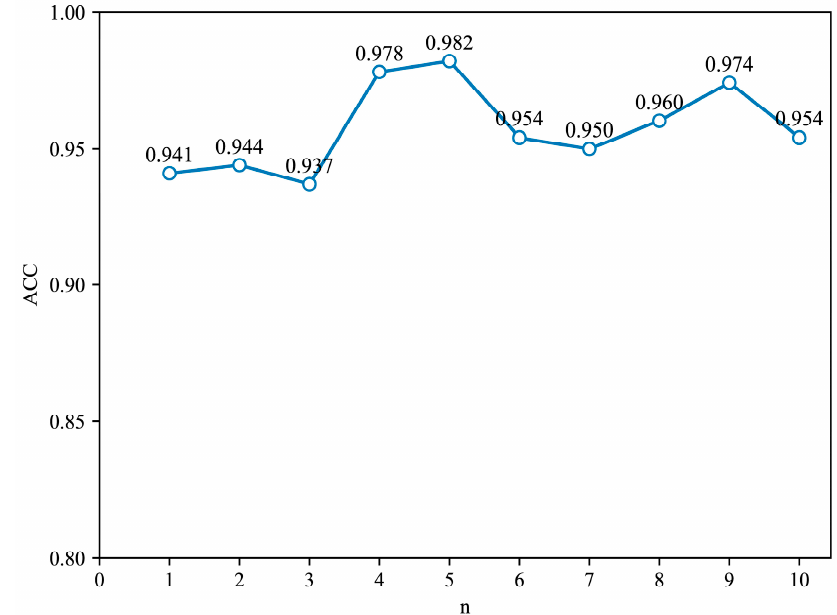
Figure 7. The detection accuracy of different hops.